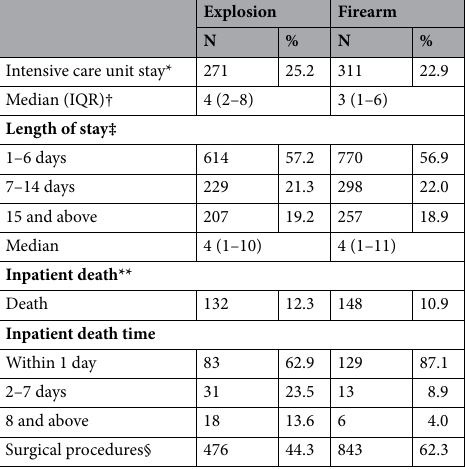
Table 5. Characteristics of injury, death, and hospitalization according to injury mechanism. * χ 2 tests for P